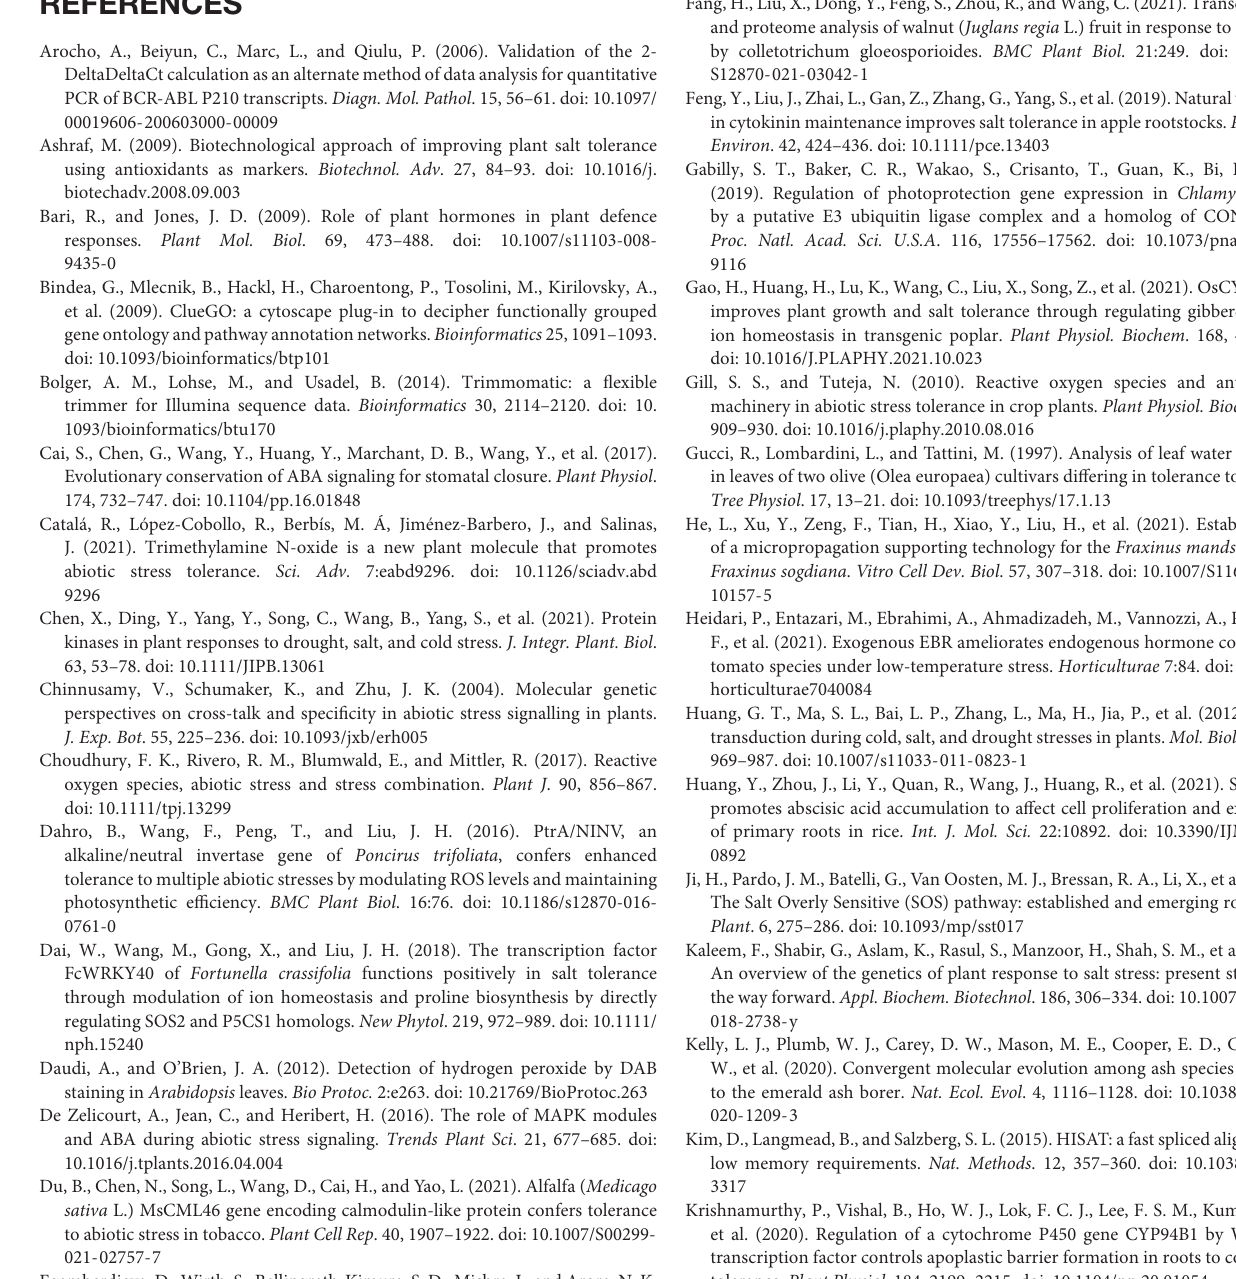
comparisons S4SL vs. S4CL, R7CL vs. S4CL, R7SL vs. S4SL, and R7SL vs. R7CL based on Z-score. The color represented the Z-score. From blue to red represented the Z-score from low to high. (B) Venn diagram showed the distribution of upregulated and downregulated DEGs among different comparisons, respectively. Supplementary Figure 3 | Identification of the differentially expressed genes (DEGs) in roots. (A) Heatmap showed the expression patterns of DEGs in